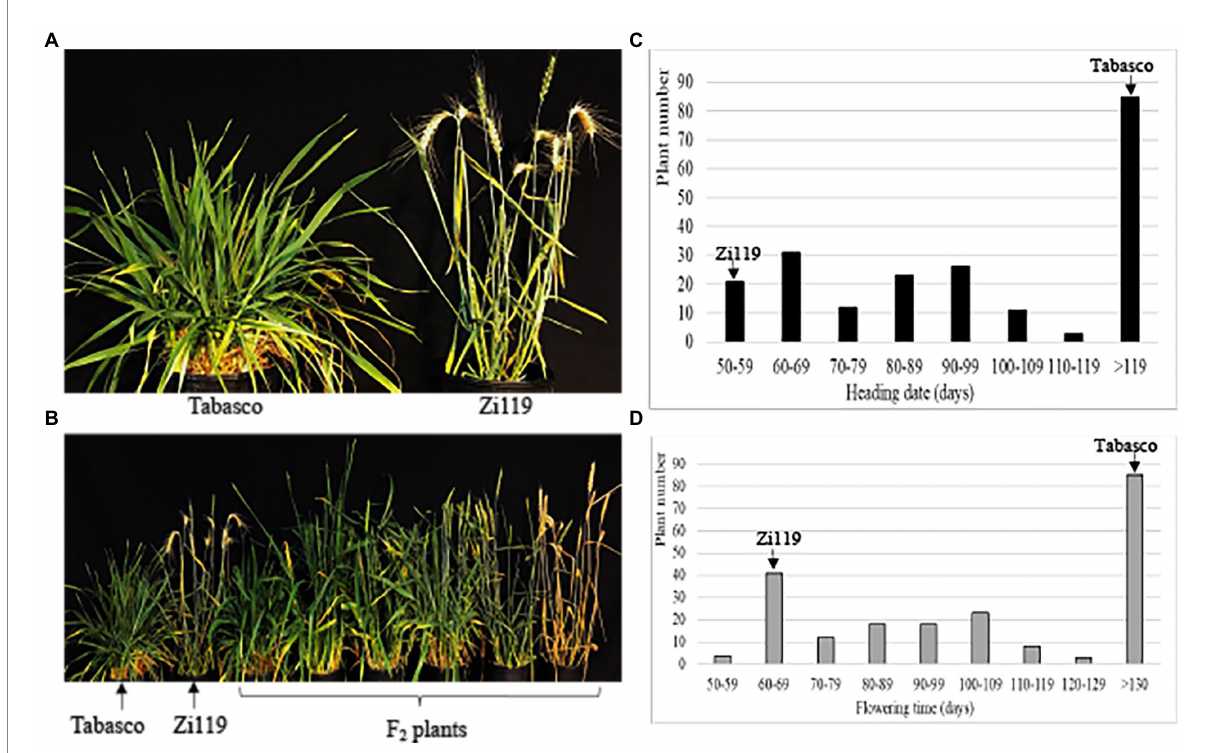
FIGURE 1 Difference in developmental phases between Tabasco and Zi119. (A) Comparison of heading date between Tabasco and Zi19. (B) Segregation of phenotypes in populations. (C) Frequency distribution of heading date for the F 2 population. (D) Frequency distribution of flowering time for the F 2 population. (C,D) Arrows indicate the groups the two parent lines fell into based on their phenotypes. The AX plus eight-digit single nucleotide polymorphism (SNP) codes are markers from SNP